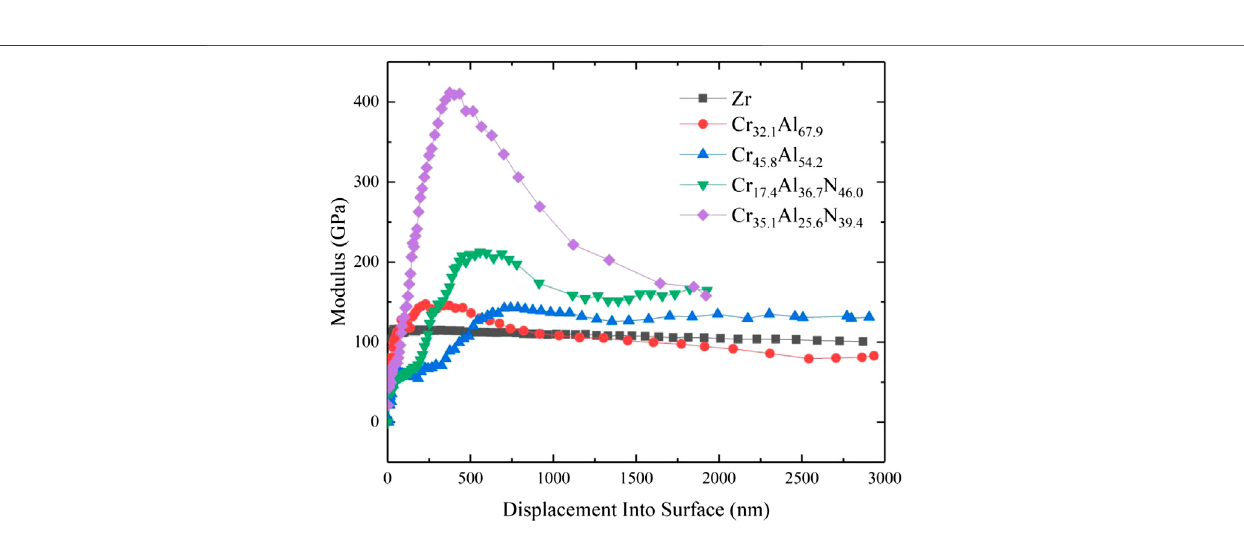
Frontiers in Energy Research |